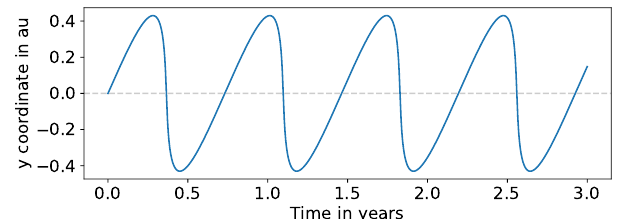
Fig. 110.— The y coordinate of our simulated planet over time